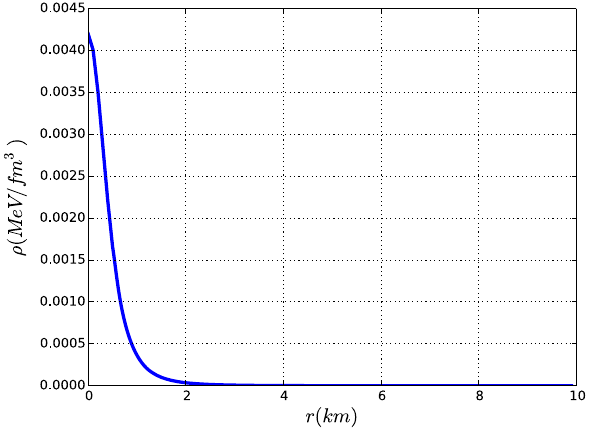
Fig. 10 Weak dominant energy condition against radial distance r